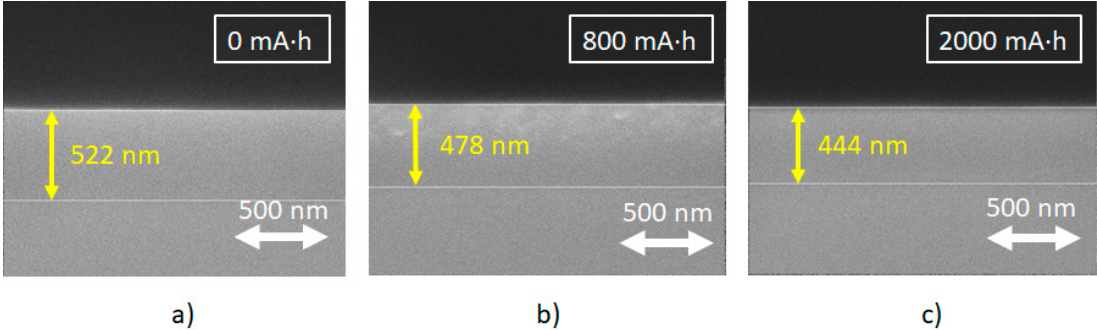
Figure 1. Cross-section of the hydrogenated silicon-containing diamond-like carbon (Si-DLC) films ( a ) before irradiation, and after irradiation of ( b ) 800 mA·h and ( c ) 2000 mA·h, observed using SEM.